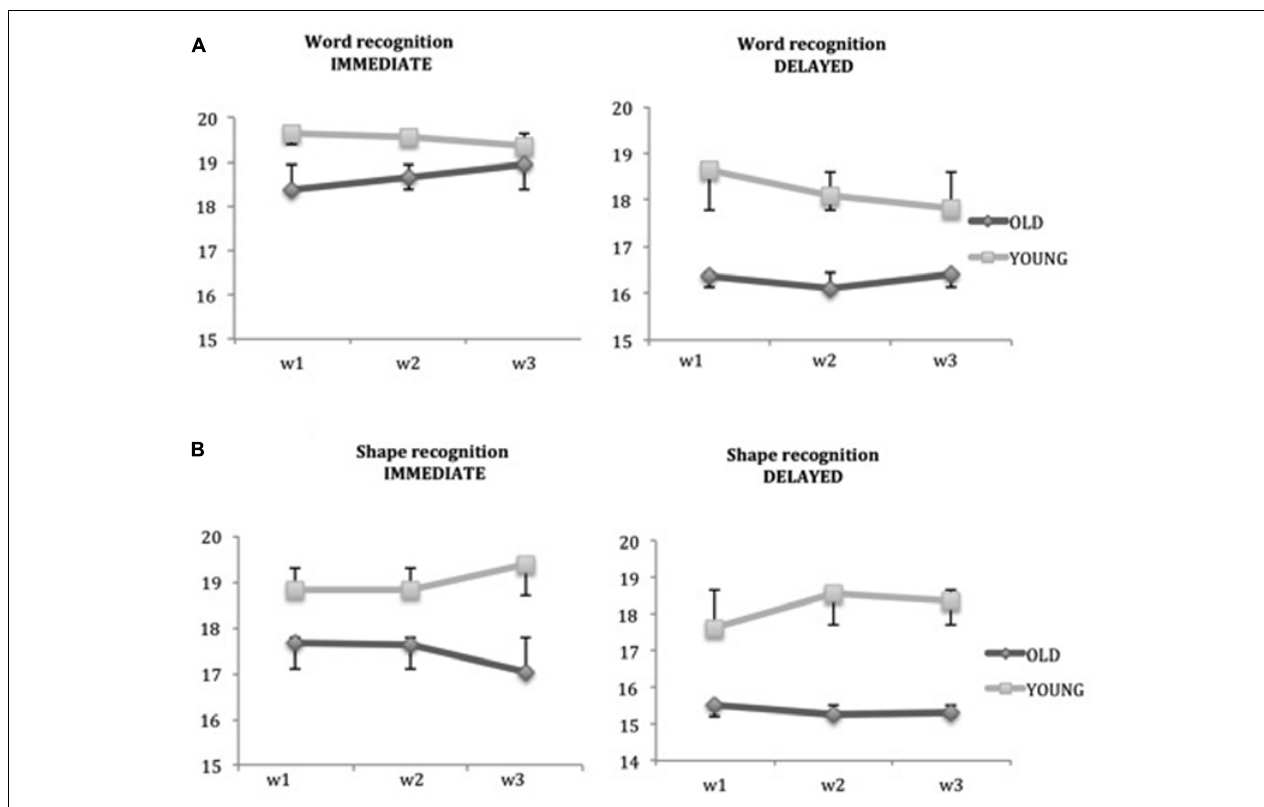
FIGURE 2 |Absence of learning effects in the verbal memory tests. (A) Immediate and delayedWord Recognition test. (B) Immediate and delayed Shape Recognition test. Mean scores and standard deviations of